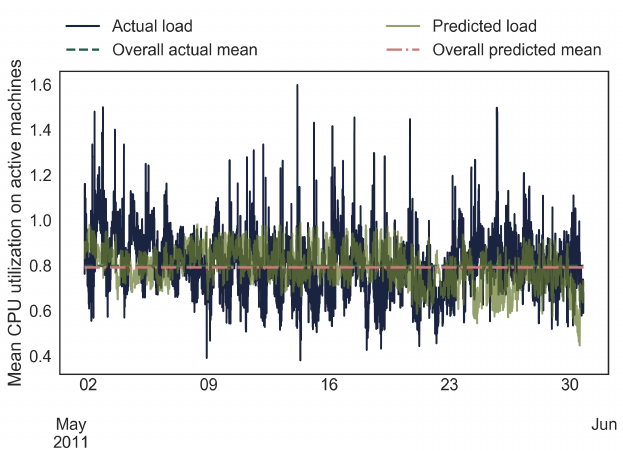
Figure 5. Predicted and actual mean CPU utilization on the active machines, for each 5 min interval and